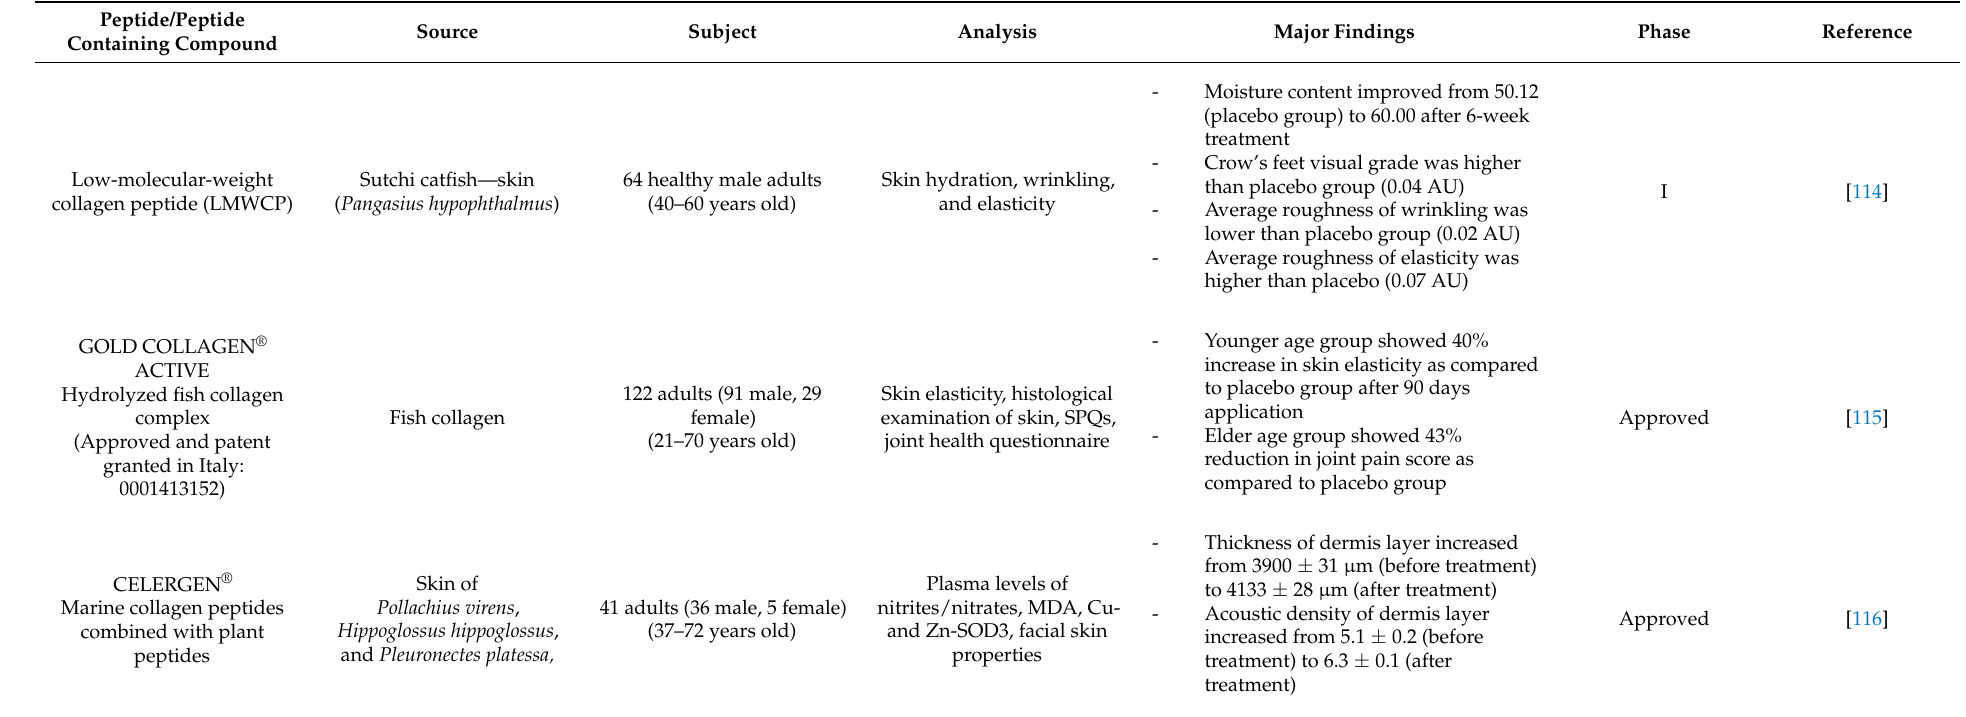
Table 3. Antioxidant effects of bioactive peptides from marine animals—clinical